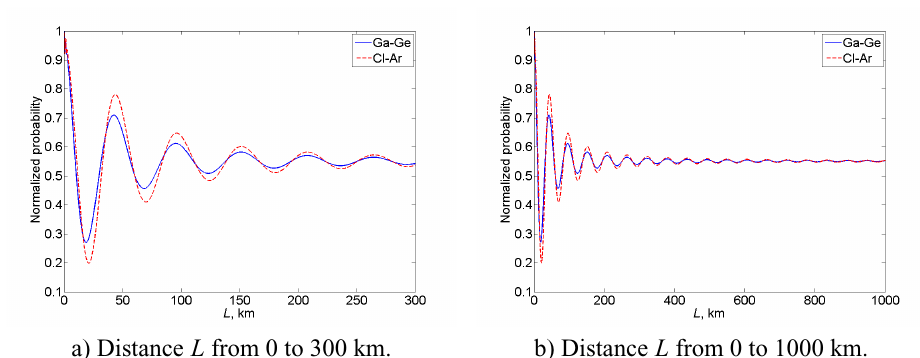
Figure 2. Normalized probabilities of the neutrino oscillation processes with the neutrino production in the 15 O decay and the registration by Cl-Ar and Ga-Ge